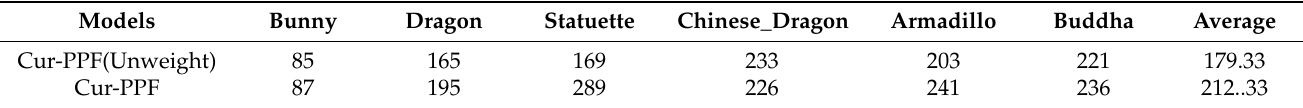
Table 4. Time using of Cur-PPF(Unweight) and Cur-PPF algorithms on public data set (ms/scene).